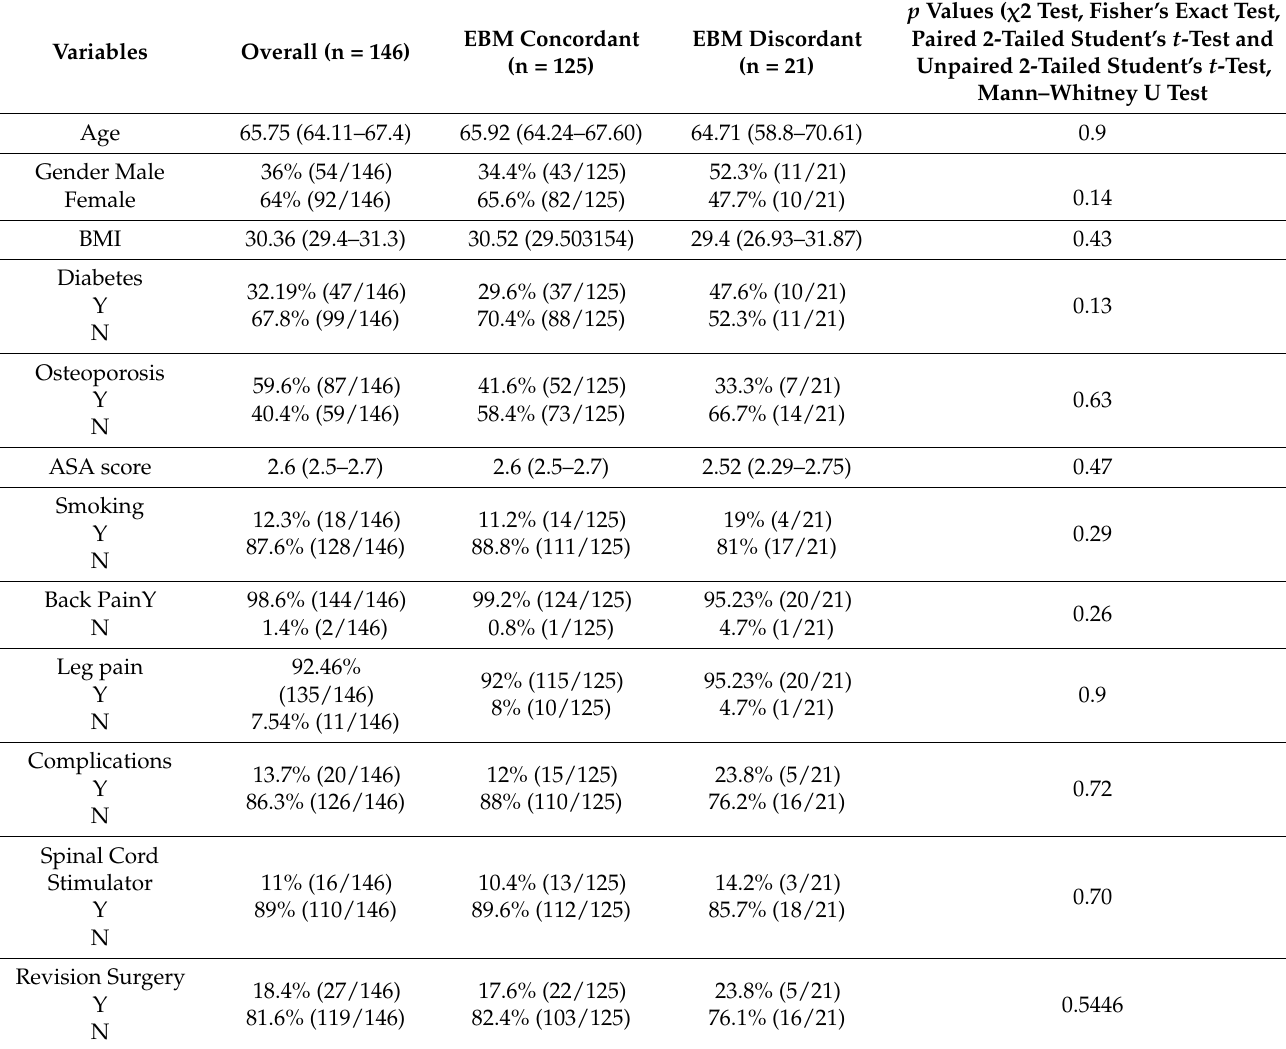
Table 1. Demographic analysis of patients based on their concordance with the evidence-based medicine (EBM)